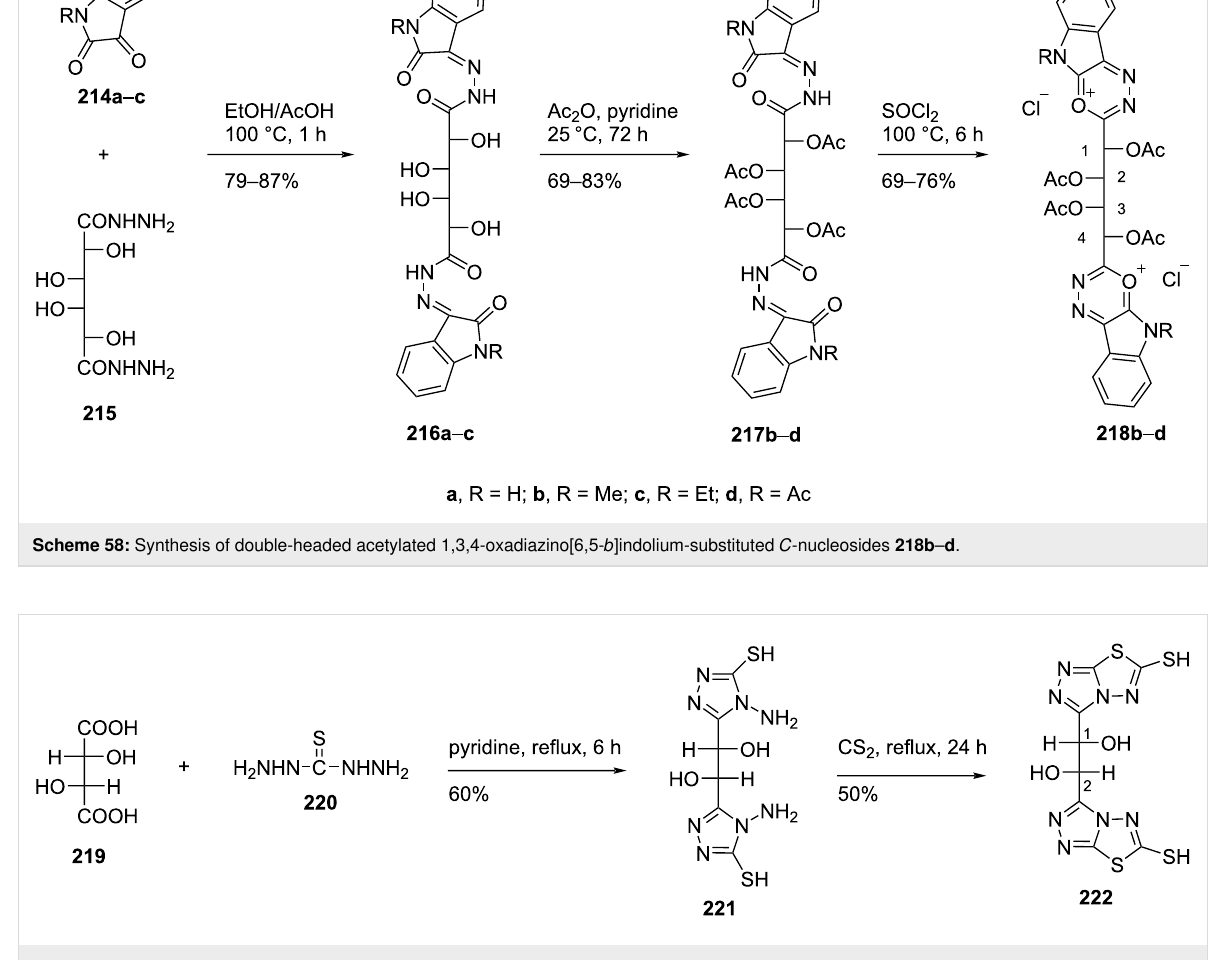
Scheme 59: Synthesis of double-headed acyclic nucleoside 222